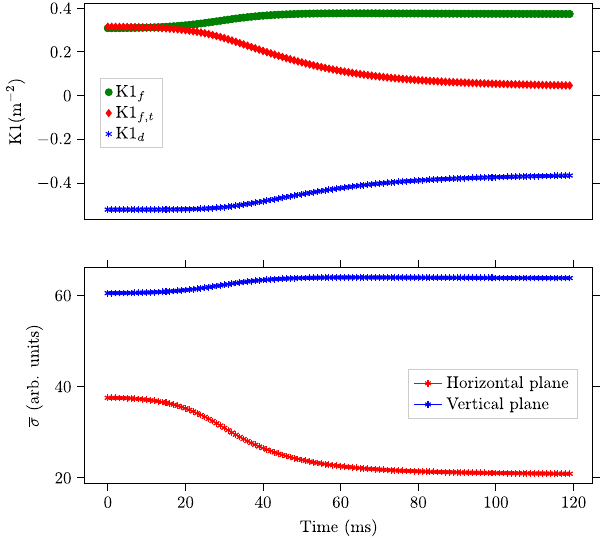
FIG. 4. Top: Triplet to doublet quadrupole transition over the ramp of 10 T = s in SIS18 (an example of optics change during ; K 1 acceleration cycle). K 1 , and K 1 are the normalized f d f;t strengths of the doublet focusing, doublet defocusing, and triplet focusing quadrupole families of SIS18, respectively. Bottom: The variation of the highest singular values of the ORM in both transverse planes, over the ramp of 10 T = ∂ B ( K 1 ¼ 1 in m − 2 ) of focusing, defocusing, and triplet ∂ z B ρ